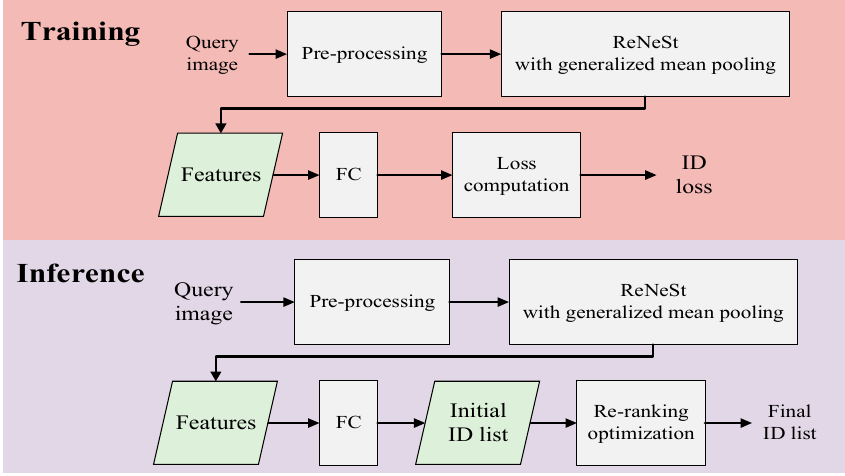
Figure 1. Framework of the proposed method.